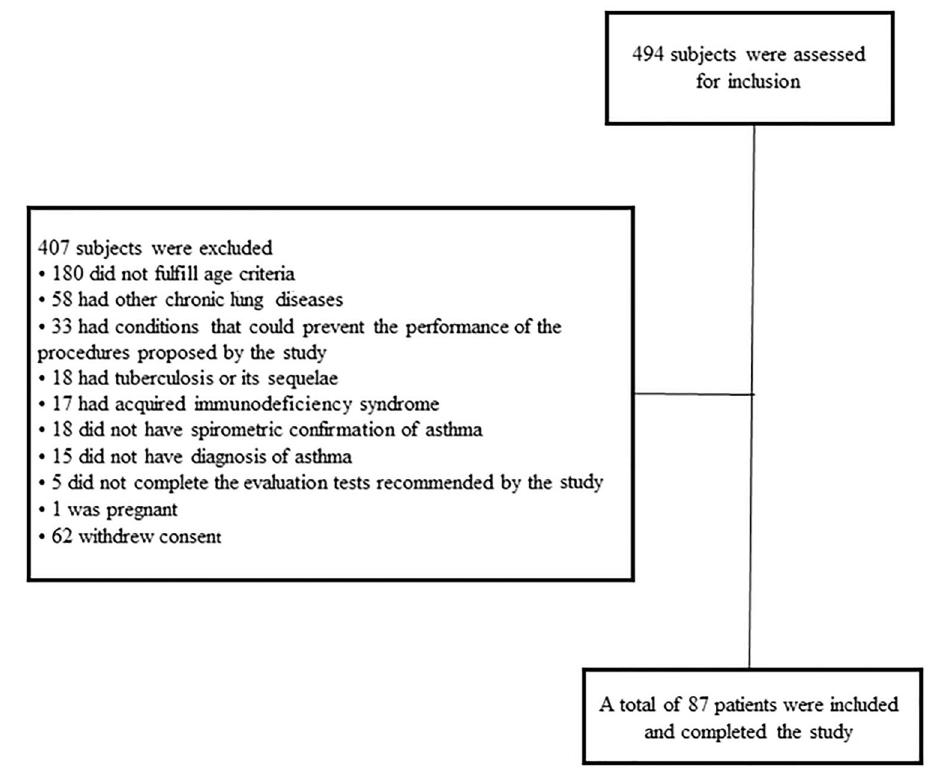
Figure 1. Flow diagram of study